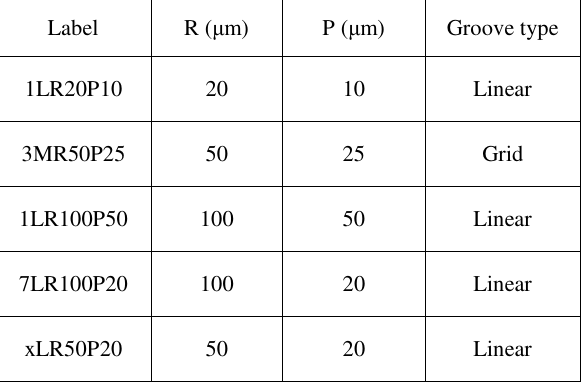
Table 1. Structures – main parameters and